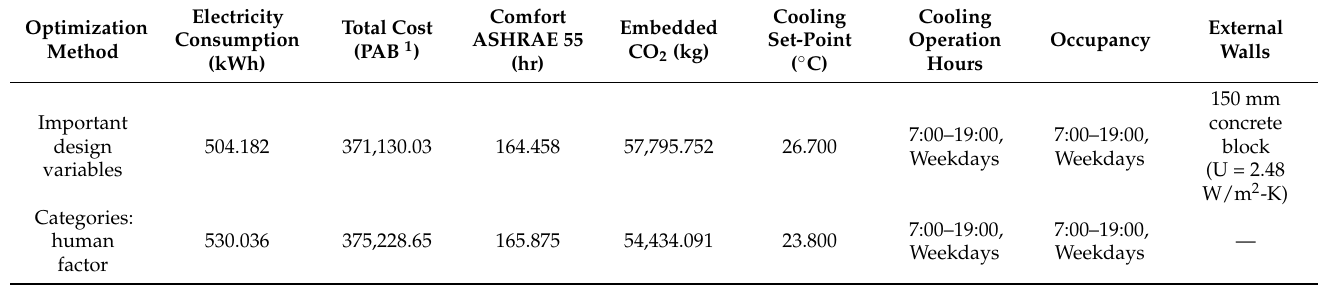
Table 6. Design options with similar results obtained in the optimization analysis according to the important design variables and human factor